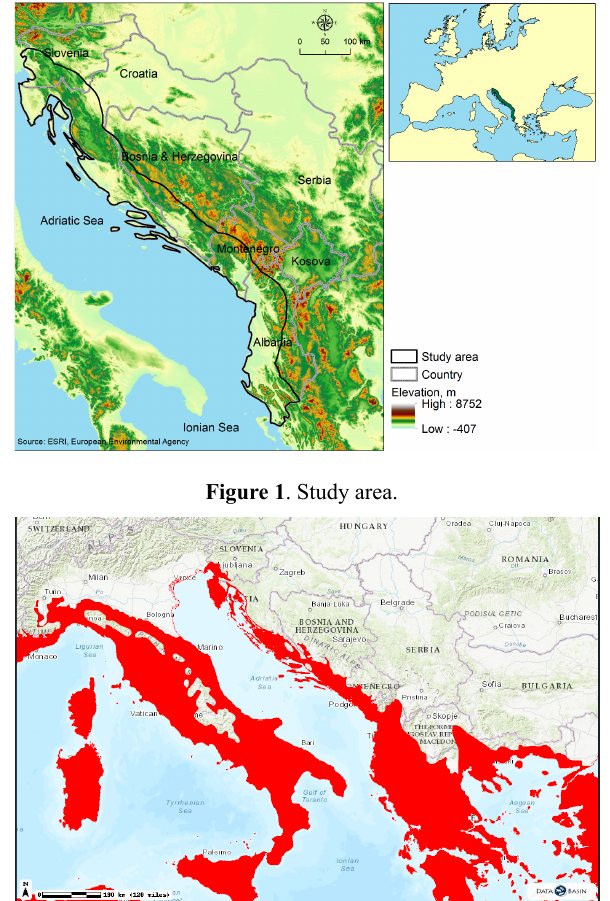
Figure 2. Biodiversity Hotspots Revisited, Conservation International, 2004. Hotspot area is in red colour.